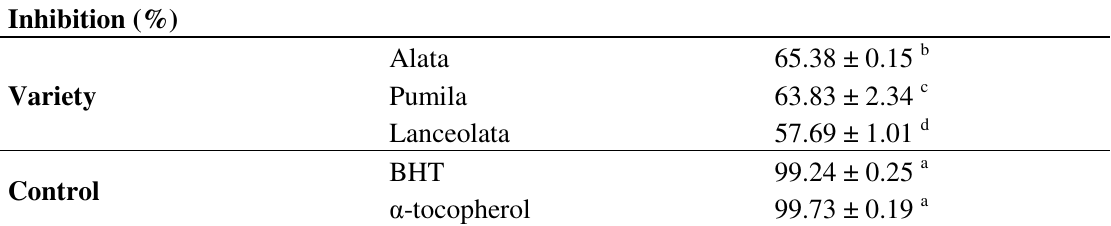
All analyses were mean of triplicate measurements ± standard deviation. Results expressed in percent of free radical inhibition. Means with different letters are significantly different from each other at p <